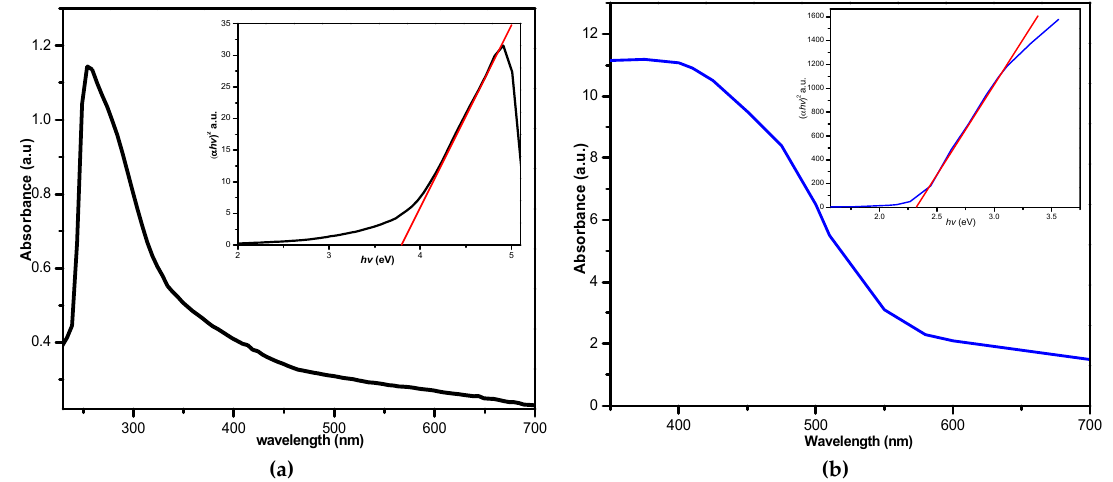
Figure 5. UV-vis spectra and Tauc’s plots (inset) of ( a ) SnO 2 and ( b ) SnS 2 nanoparticles.